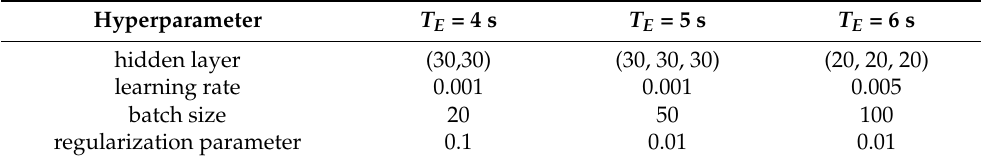
Table 1. Optimal hyperparameters of an ANN model.